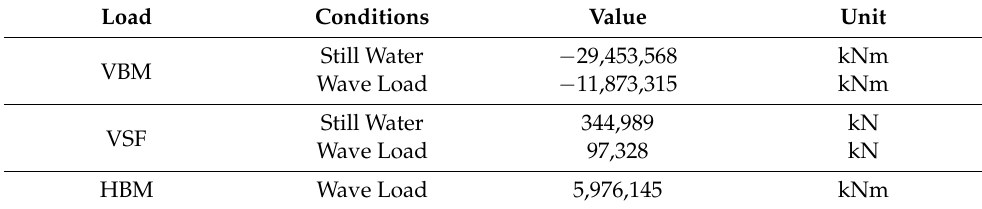
Table 4. Loads condition to be considered.